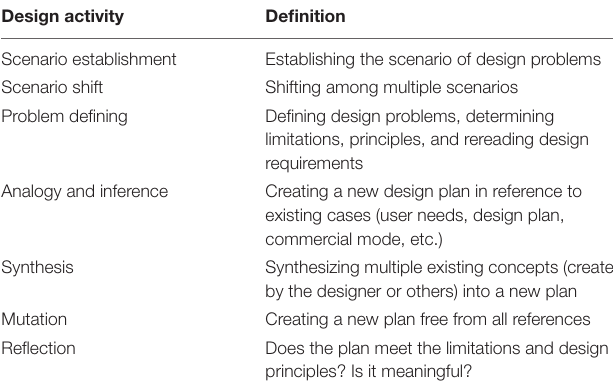
TABLE 2 | Design activities and definitions.